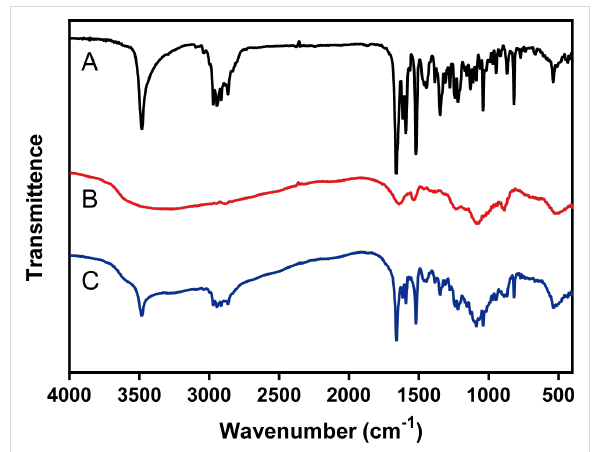
Figure 3: FITR spectra of (A) MIF, (B) blank CNs, and (C) MCNs. The MCNs formulation showed the characteristic absorption peaks of both MIF and